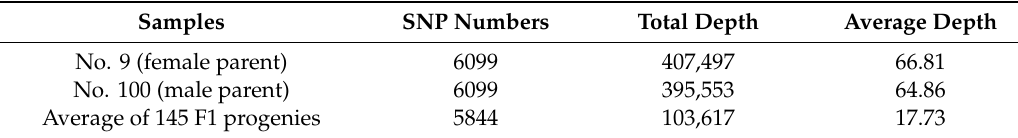
Table 1. Sequencing depths of the SNPs in the map.